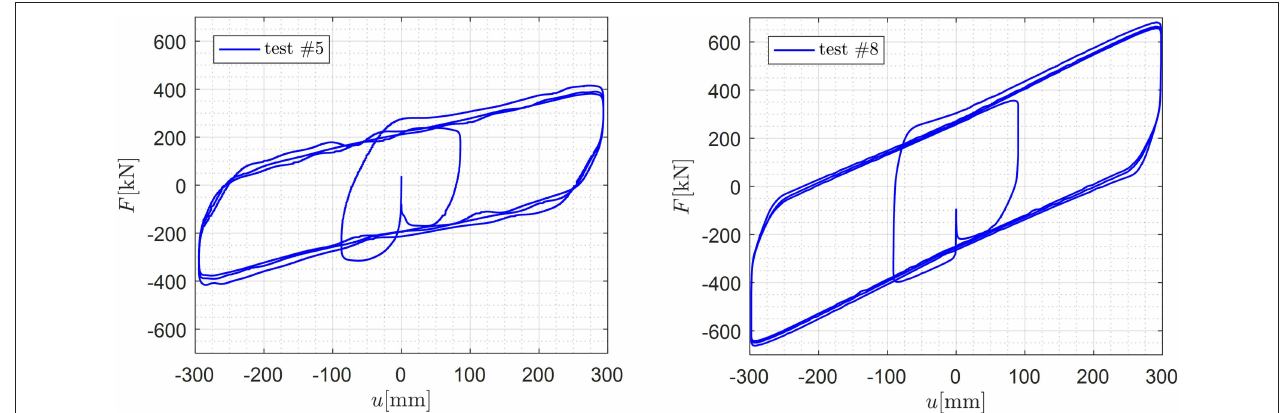
FIGURE 9 | Force-displacement loops of the DCSS prototype for test #5 (Left) and test #8 (Right)